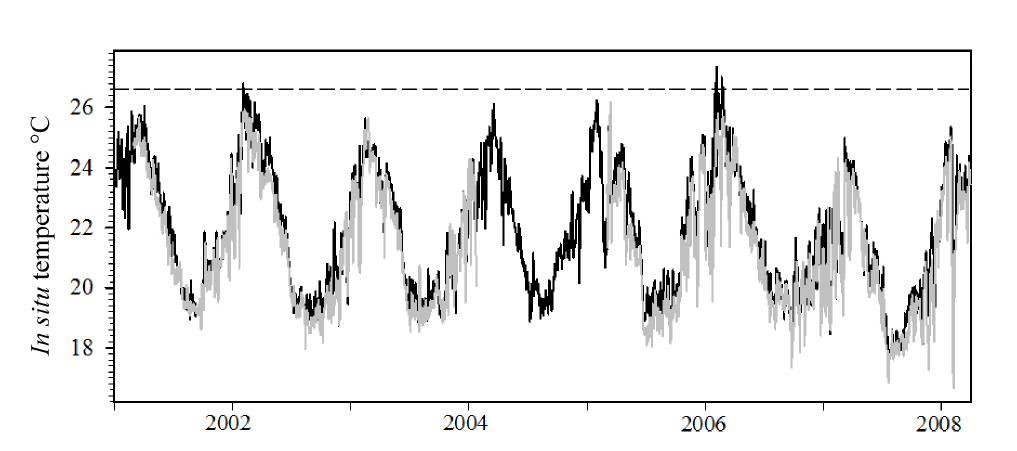
Figure 5. Mean daily in situ seawater temperature data collected at North Solitary Island (black line) and South West Solitary Island (grey line) between 2001 and 2008: Dotted line indicates hypothesized subtropical bleaching threshold for the SIMP.